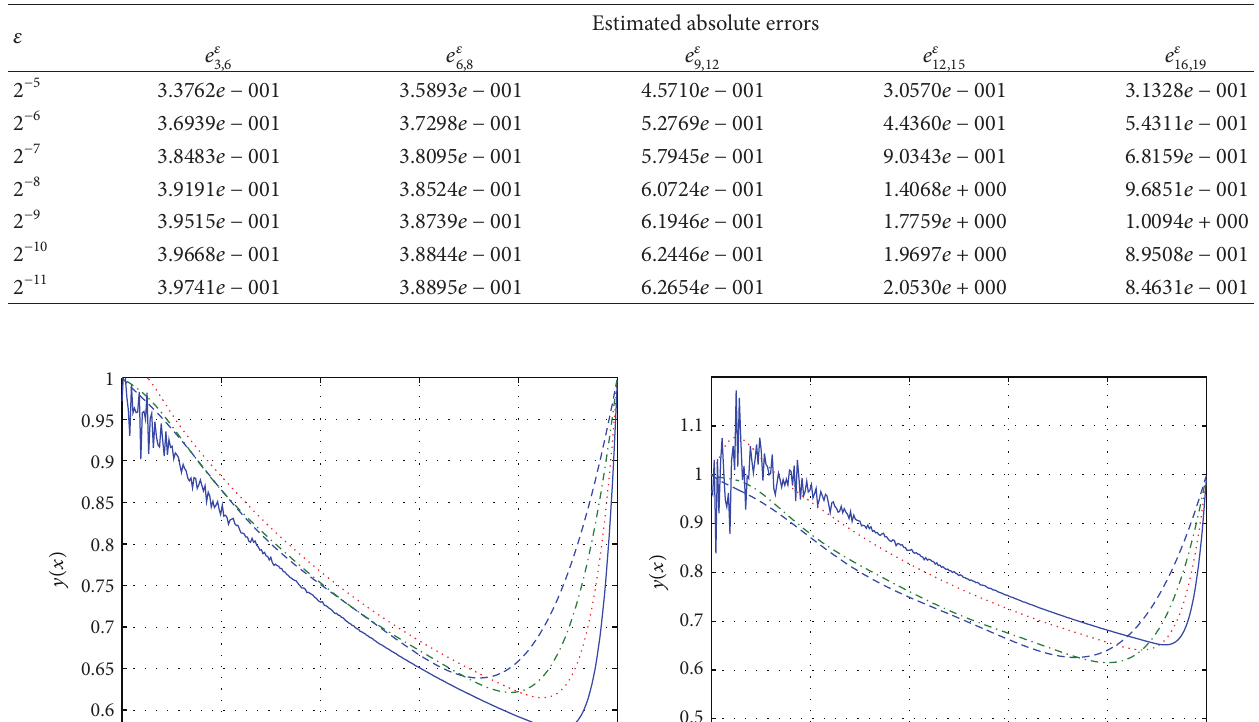
Table 2: Estimated maximum absolute errors for various values of 𝜀 = 2𝛿 , 𝑁 , and 𝑀 of (40).